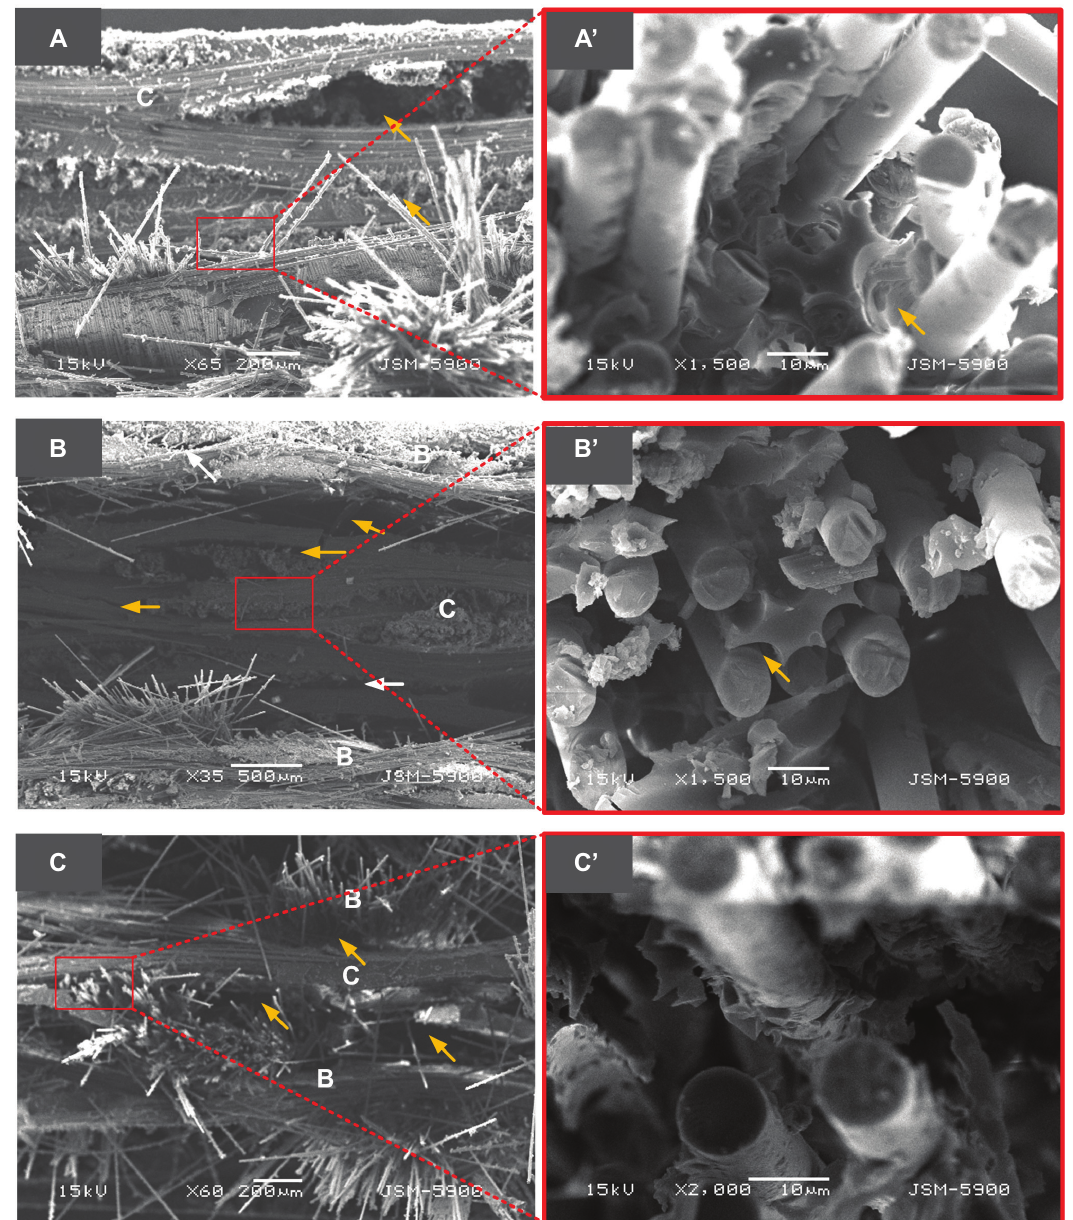
Figure 7 Low- and high-magnification SEM images for the cross section of the fracture surface of the hybrid composites: (A-A’) B4, (B-B’) BC, and (C-C’)